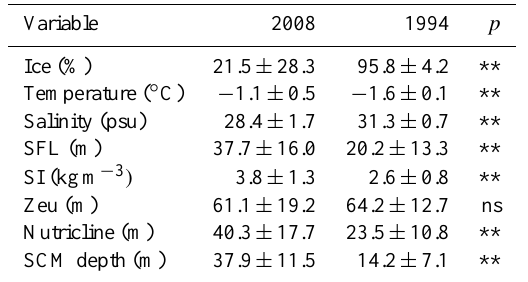
Table 3. Means ( ± SD) of several physical and chemical parameters in the Pacific Arctic (75 to 86 ◦ N) during the 1994 and 2008 cruises. The significance ( p ) of the observed differences (Student’s t -test) is shown at the confidence level ** p < 0.001; ns: not